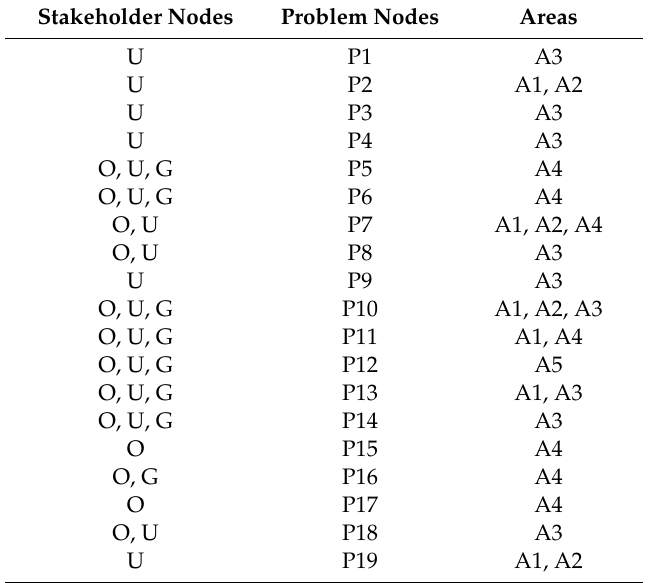
Table 5. Influencing factors (problems) with the corresponding stakeholders and areas.